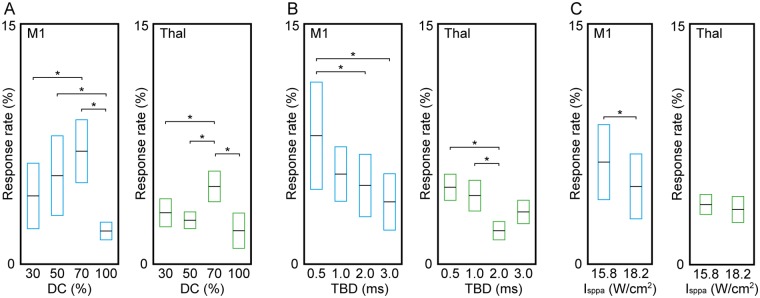
The response rate in excitatory sonication to the M1 and thalamus, comparing different DCs, tone-burst durations (TBDs), and Isppa.Averaged response rate (horizontal black line in box) with standard error (box) in contralateral EMG was plotted across the different sonication parameters in terms of (A) DC, (B) TBD, and (C) Isppa. The bracket with the asterisk indicates significant differences (one-way ANOVA with LSD post-hoc analysis in panels A and B, post-hoc test p < 0.05, and paired two-tailed t-test in panel C, p < 0.05) of the response rate between different sonication parameters.